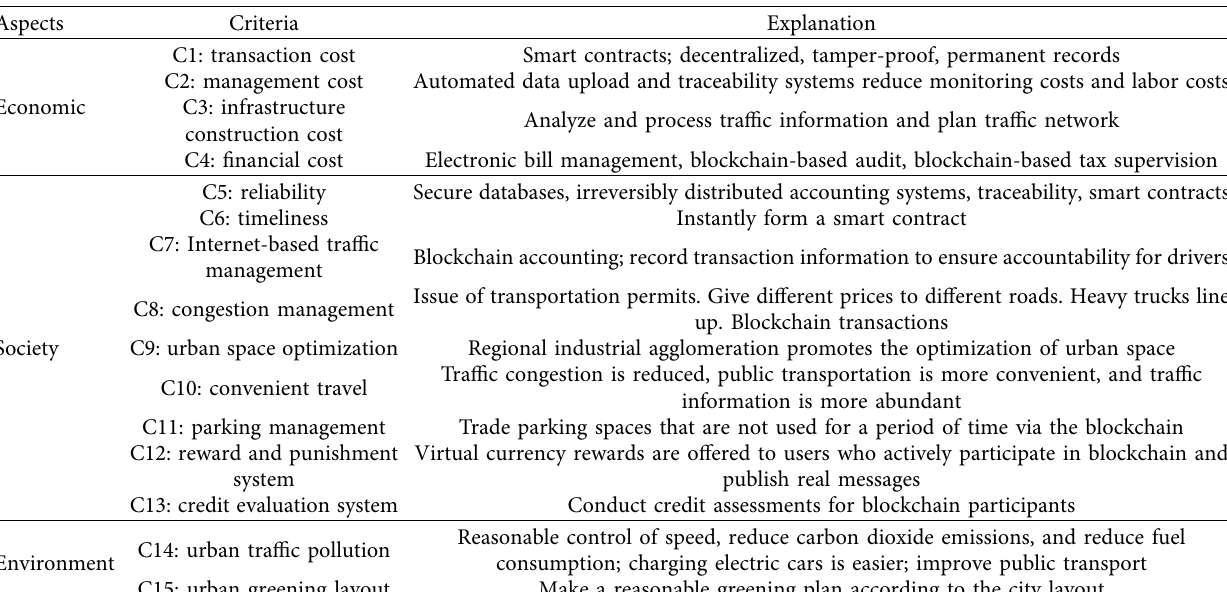
Table 1: Proposed